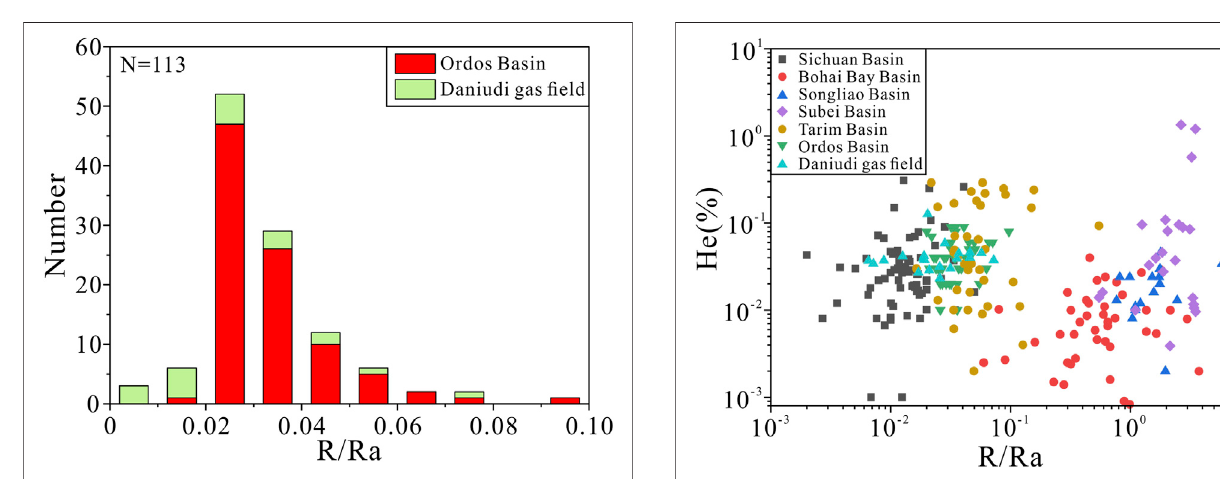
FIGURE 5 | Correlation of He (%) versus R/Ra of natural gas in the Daniudi gas fi eld and typical petroliferous basins in